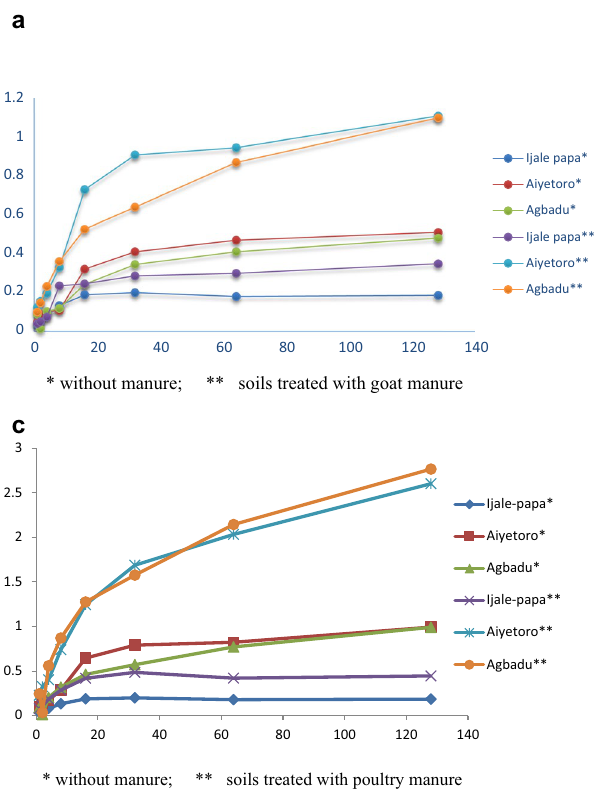
and Ipetumodu/Agbadu soils. Asterisk without manure; double aster- isk soils treated with poultry manure. d Potassium released from Ojere, Olorunda, and Ilewo–Orile